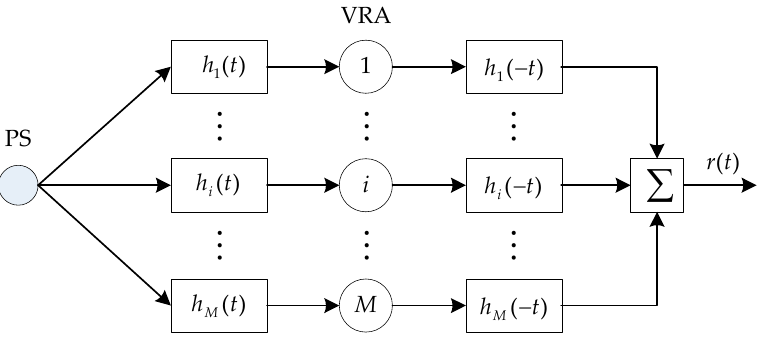
Figure 1. Block diagram of TR combining.